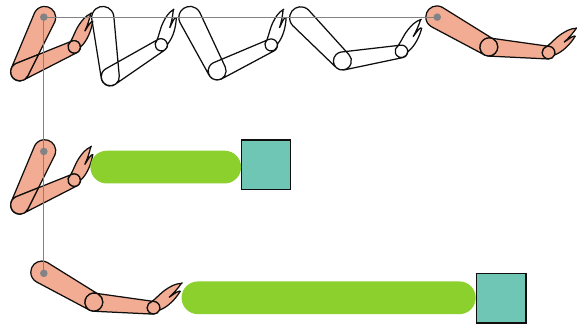
Figure 1: Metaphor of physical arm motion. The position of the arm in the user’s exploration (extending) action corresponds to the distance to the object.